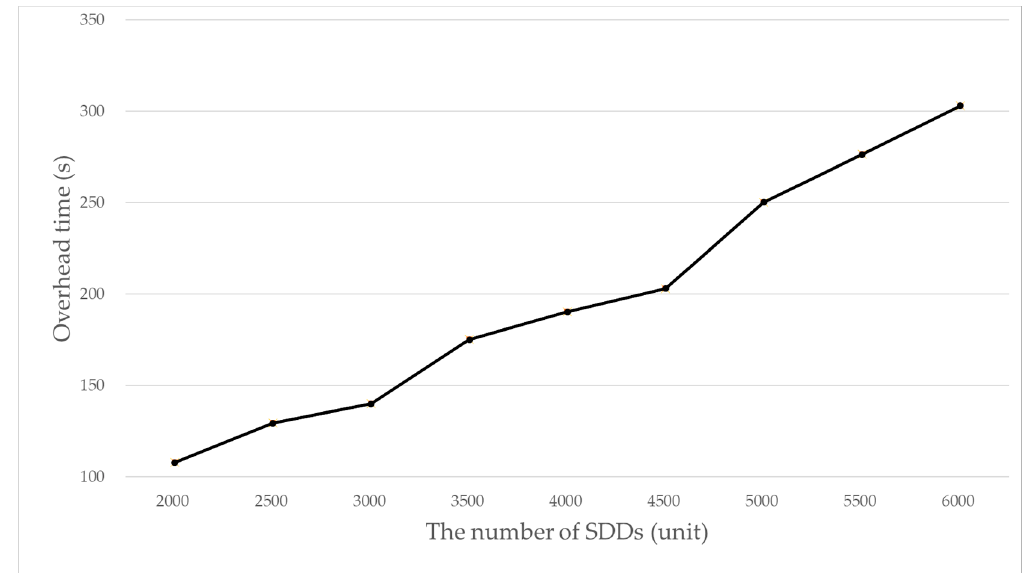
Figure 13. The overhead time required for the tree transformation.